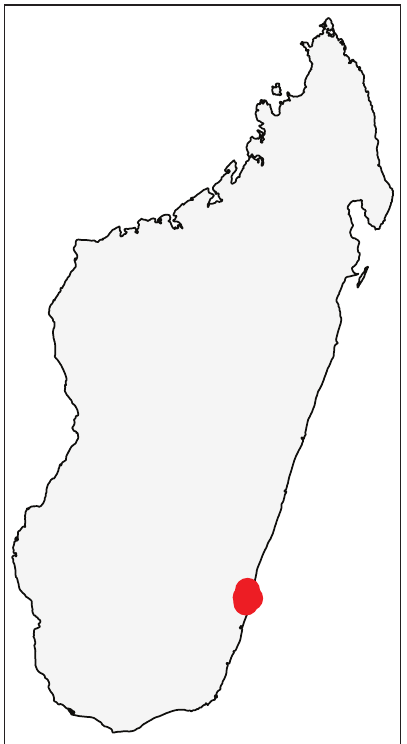
Figures 37. Geographic distribution of Nesomyrmex minutus sp. n.. The known localities of N. minutus sp. n. in